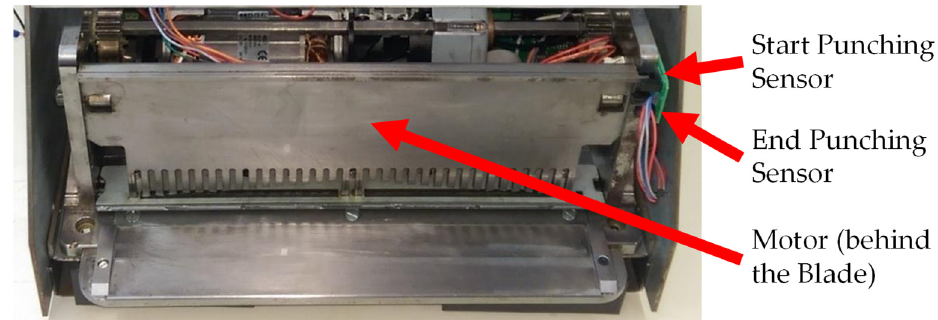
Figure 10. Punching system.